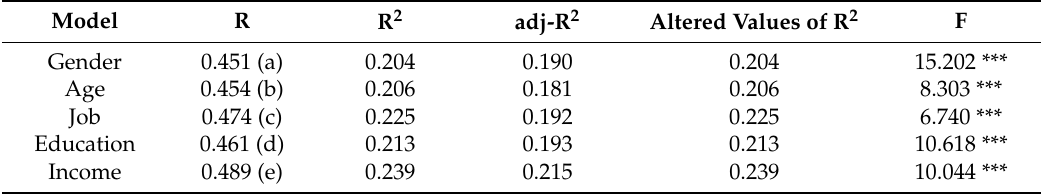
Table 6. Summary of residents’ personal characteristics and TOD living